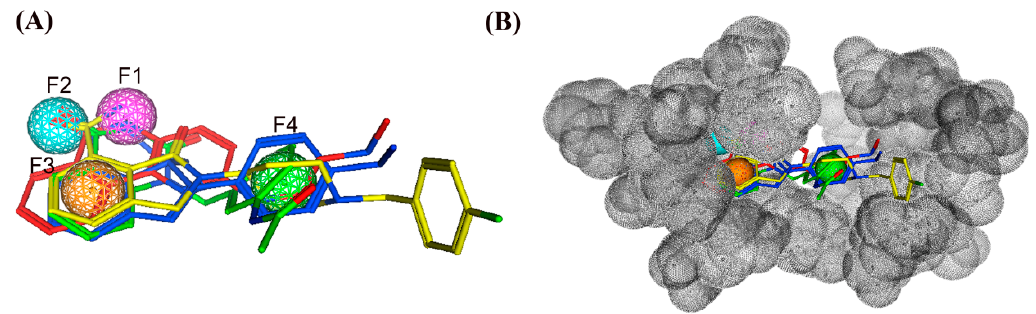
Figure 4. ( A ) The pharmacophore mapping of four selected compounds on the model. Pharmacophore features are color-coded: purple, one hydrogen bond donor feature (F1: Don); cyan, one hydrogen bond acceptor feature (F2: Acc); orange, one aromatic feature (F3: Aro); green, one hydrophobic feature (F4: Hyd). ( B ) A steric constriction (dark gray) was added to the pharmacophore model.